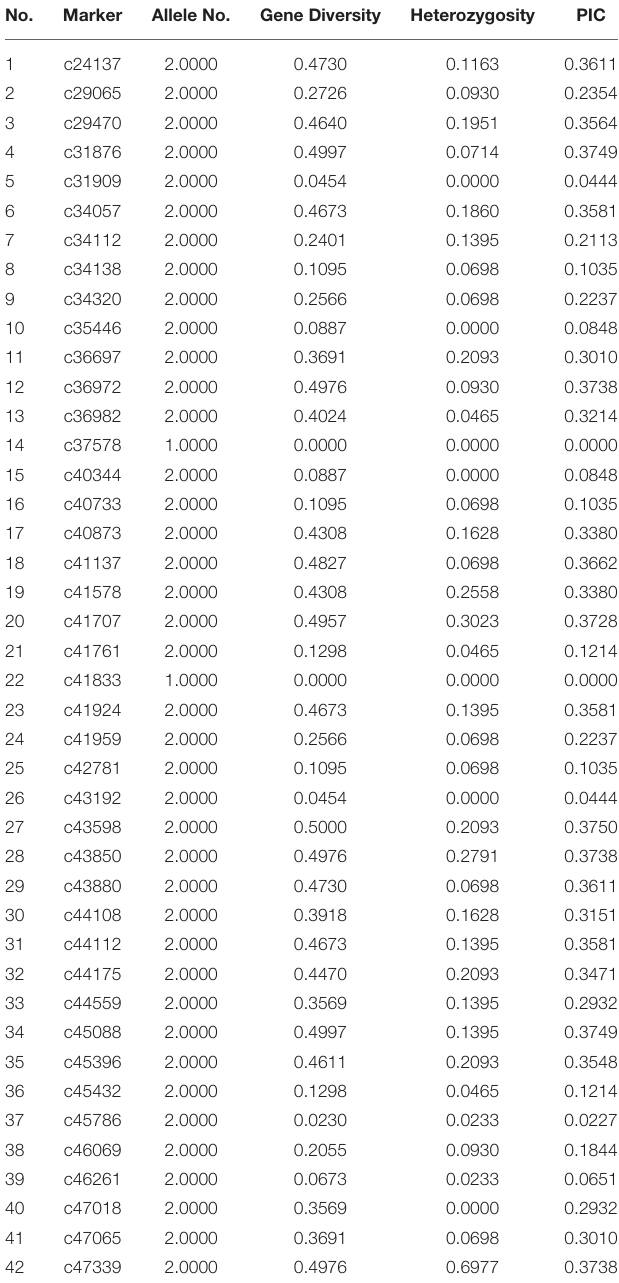
TABLE 3 | Results of 42 KASP primers screening in 43 accessions of Lathyrus sativus L. No.